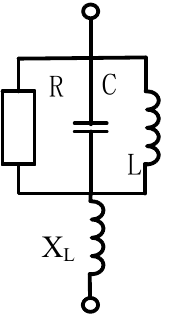
Figure 5. Equivalent circuit of the circular microstrip antenna.